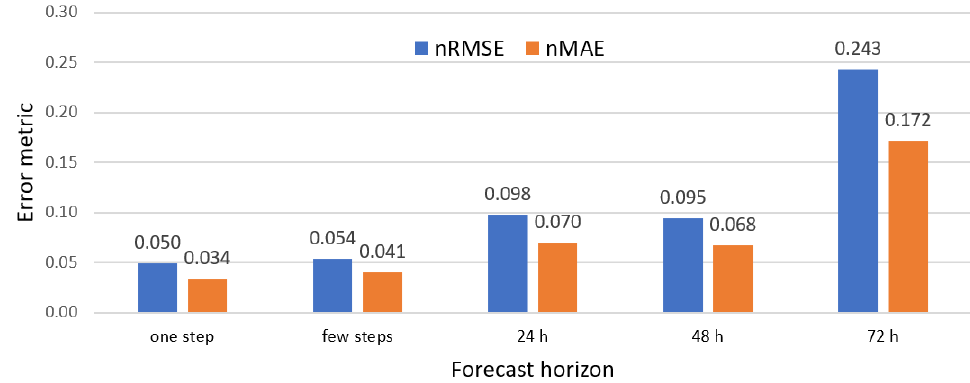
24 of 39 Figure 10. nMAE errors with a note on forecasting horizon, in ascending order. Figure 11 presents how the amount of error depends on the forecasting horizon. This figure summarizes information from Figures 9 and 10—average values for both metrics were calculated for selected forecasting horizons. In general, average errors grow with increasing forecasting horizon, although, for the 24 h horizon, average errors are slightly more than for the 48 h horizon. This is probably due to the fact that there were significantly fewer papers describing forecasts with a 48 h horizon than with a 24 h horizon (random element of lower errors from a small number of samples). By far the largest were the av-